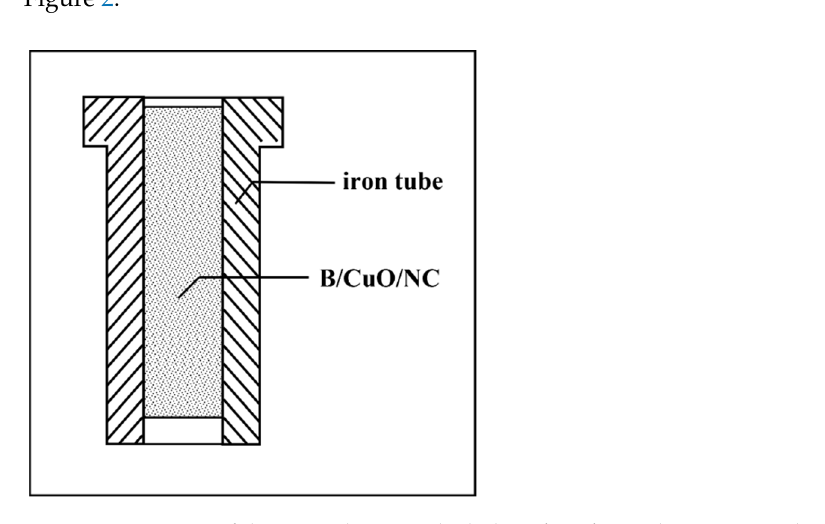
Figure 2. Structure of the iron tube into which the B/NC/CuO thermite sample is